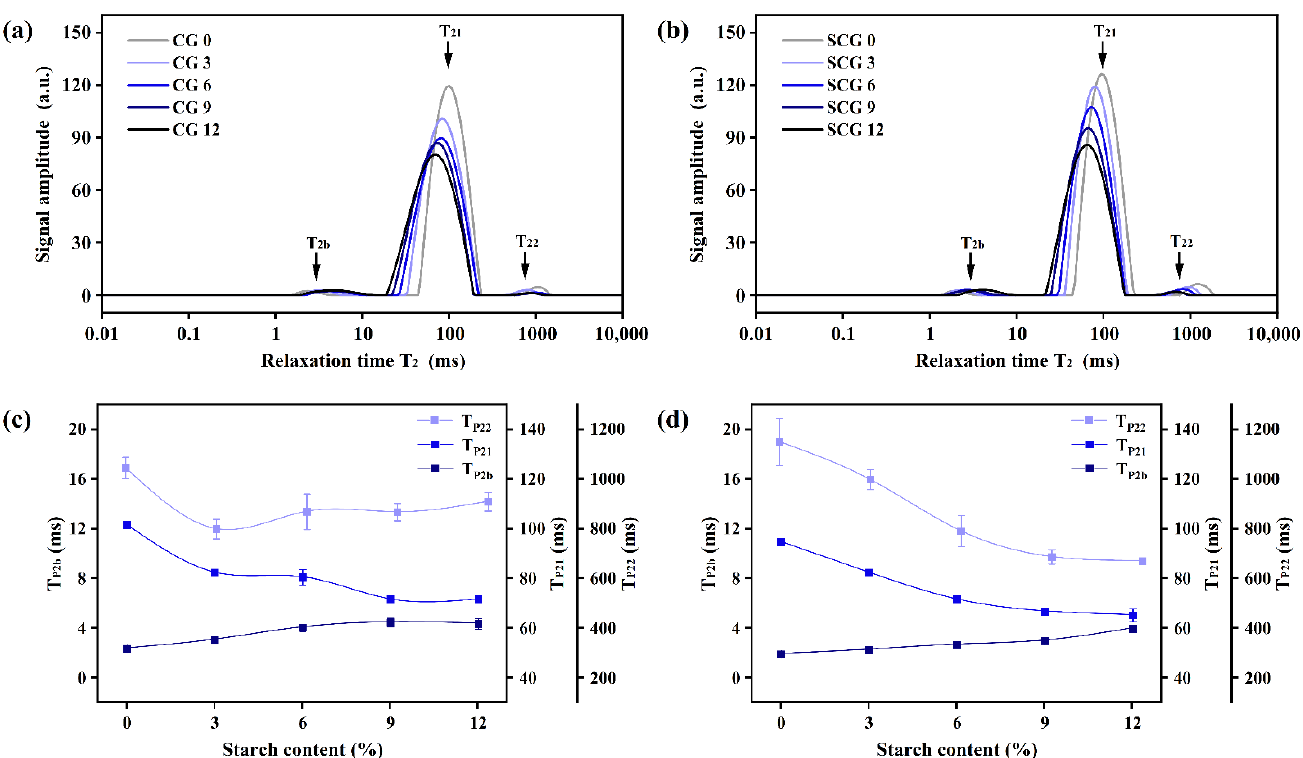
Figure 1. T 2 relaxation time ( a , b ) and water mobility ( c , d ) of starch–surimi matrix in direct heating process and two-step heating process. CG: gel obtained by direct heating; SCG: gel obtained by two-step heating. 0: without starch; 3, 6, 9, and 12: incorporation with 3%, 6%, 9%, and 12% starch.